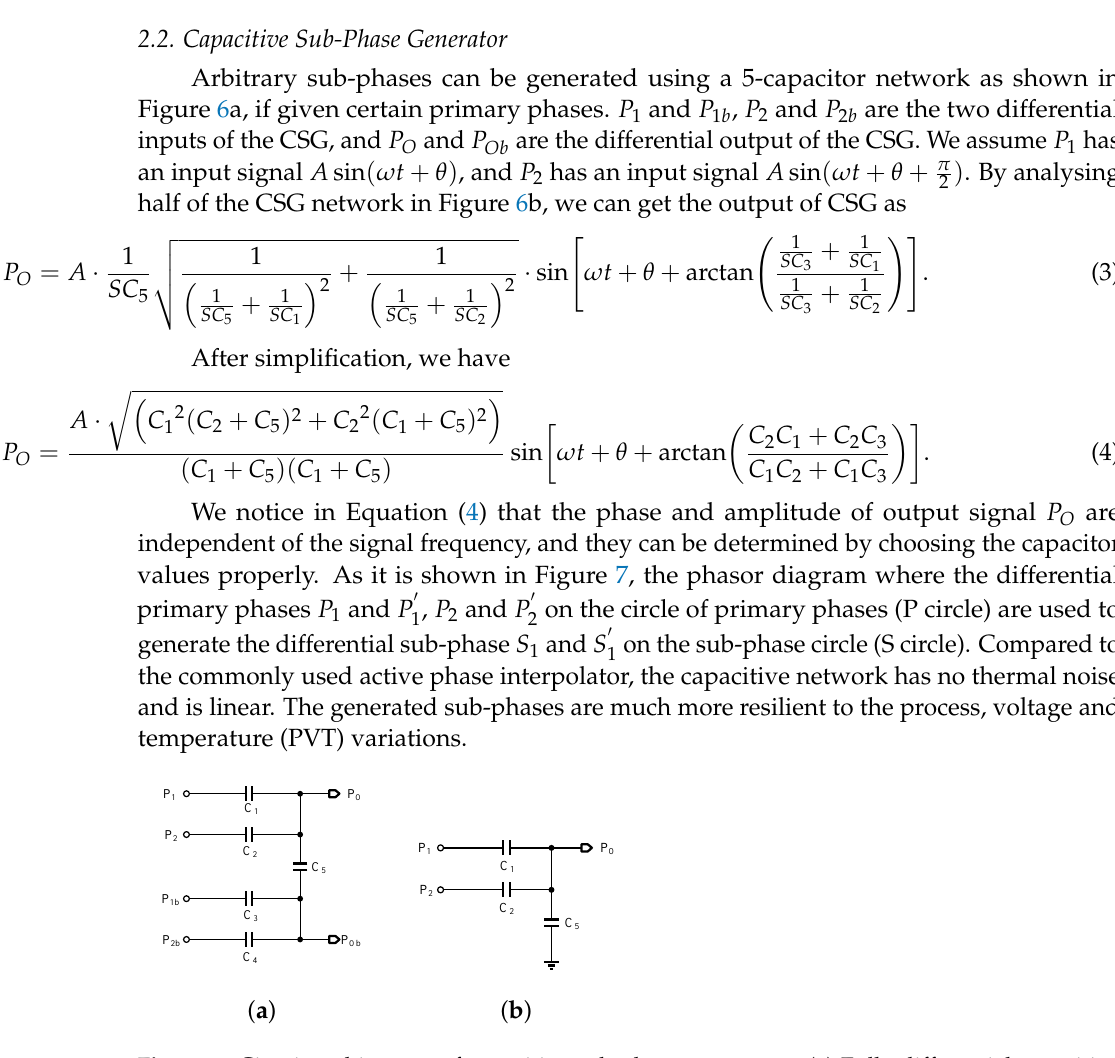
Figure 6. Circuit architecture of capacitive sub-phases generator. ( a ) Fully differential capacitive network for sub-phase signal generation. ( b ) Half capacitive network for sub-phase signal generation.